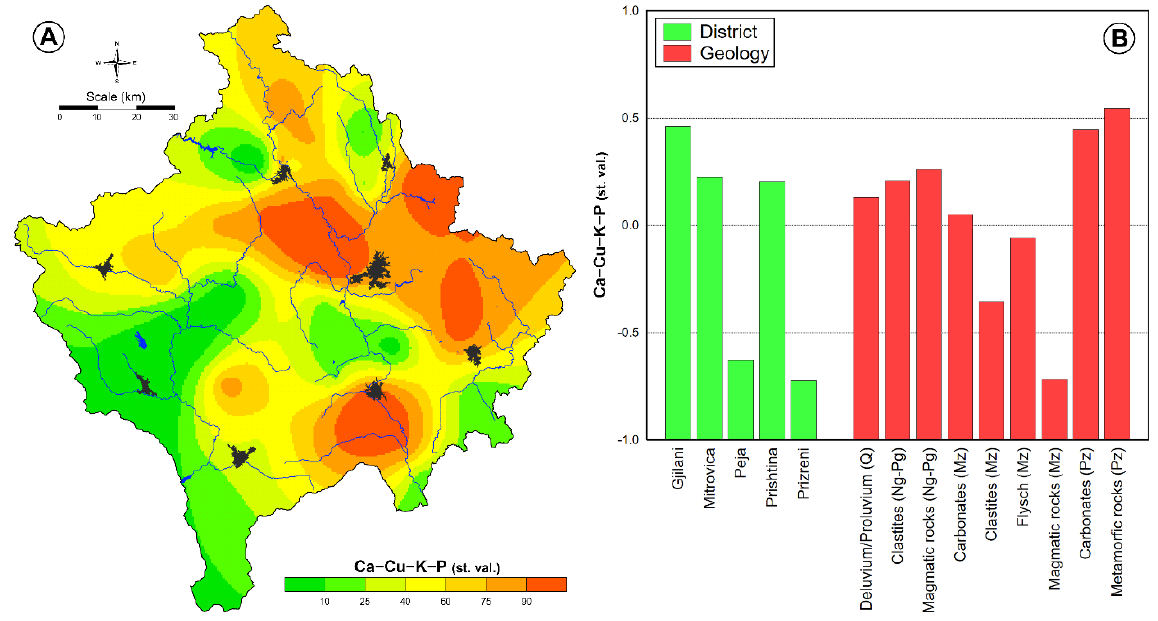
Figure 7. Spatial distribution of factor scores of F3 ( A ) and standard values according to the Districts and geological formations ( B ).